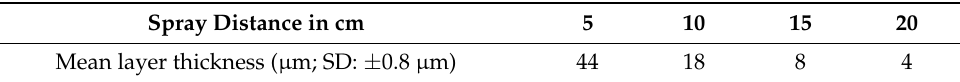
Table 2. The table shows the applied mean layer thickness of hydrogel per spray (measured in microns) applied to the sensor-structure with the method described above.